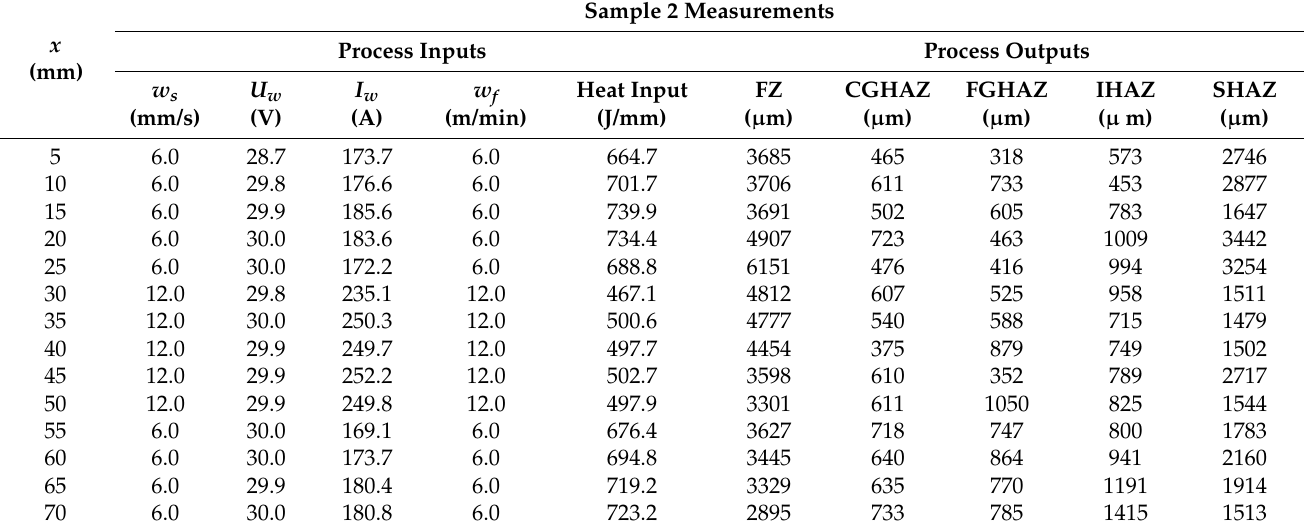
Table 5. Measurements corresponding to sample